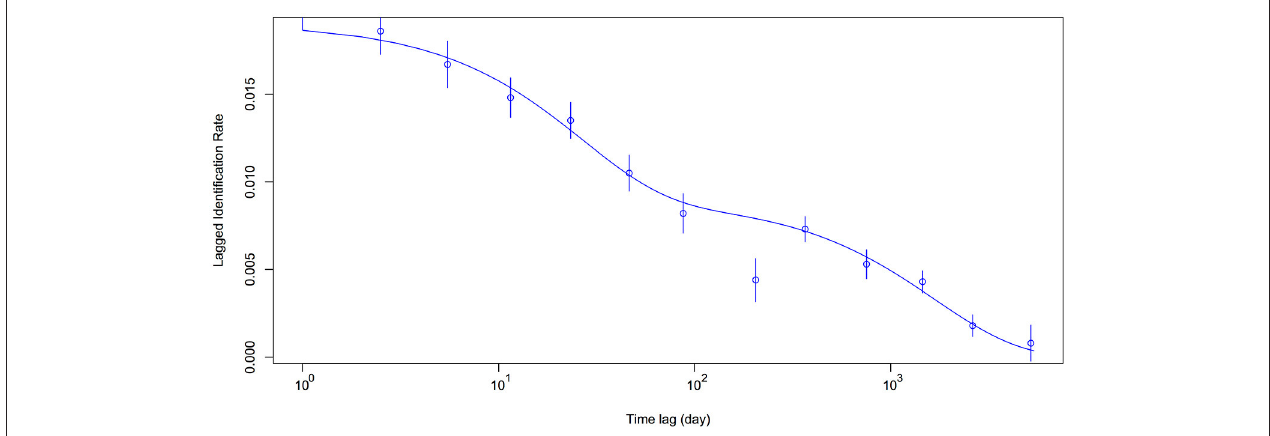
FIGURE 5 | Lagged Identification Rate (mean ± S.E.) for whale sharks at Donsol. Model parameters included emigration, reimmigration and mortality as preset in SOCPROG 2.7 (Whitehead,